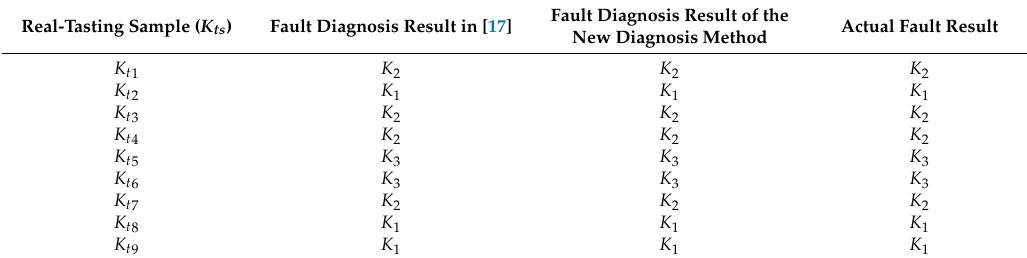
Table 8. Various misfire fault diagnoses and actual misfire fault results of the gasoline engine EQ6102. Real-Tasting Sample ( K ts )